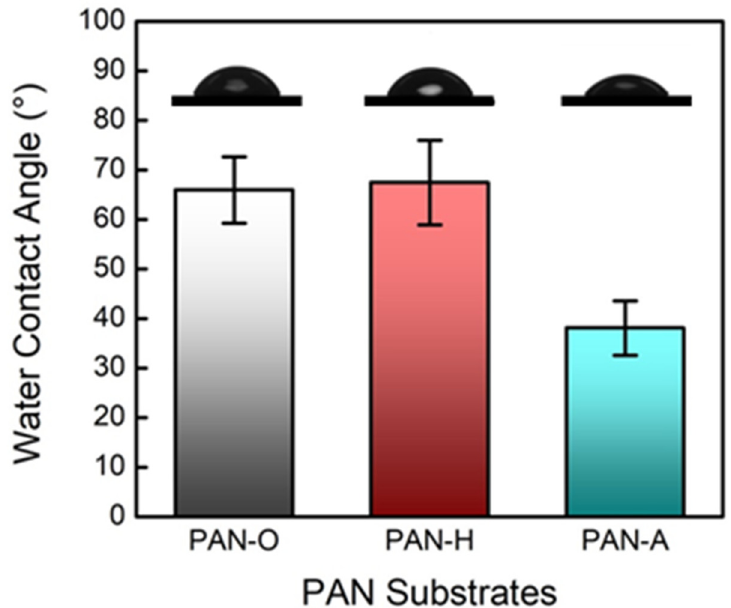
Figure 1. Comparison of the contact angles measured on the surface of the original PAN substrate and the PAN substrates with the heat treatment and alkaline treatment. The error bars correspond to the standard deviations of the characterization results (nine measurements using three membrane samples).